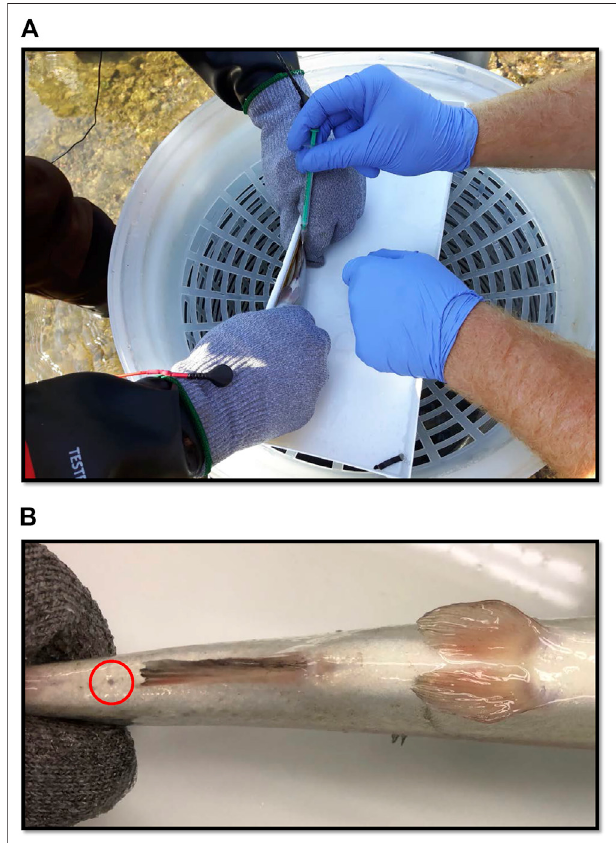
FIGURE 1 | (A) Blood being sampled from a rainbow trout (100 g) in the fi eldwithaneedleand syringe. (B) Small scar(circledinred)whichoccurredin 7 of 20 blood sampled fi sh in the fi eld. The mark is the only discernible feature between healthy controls and fi sh whose blood had been sampled. Photograph was taken after 3-weeks of recovery